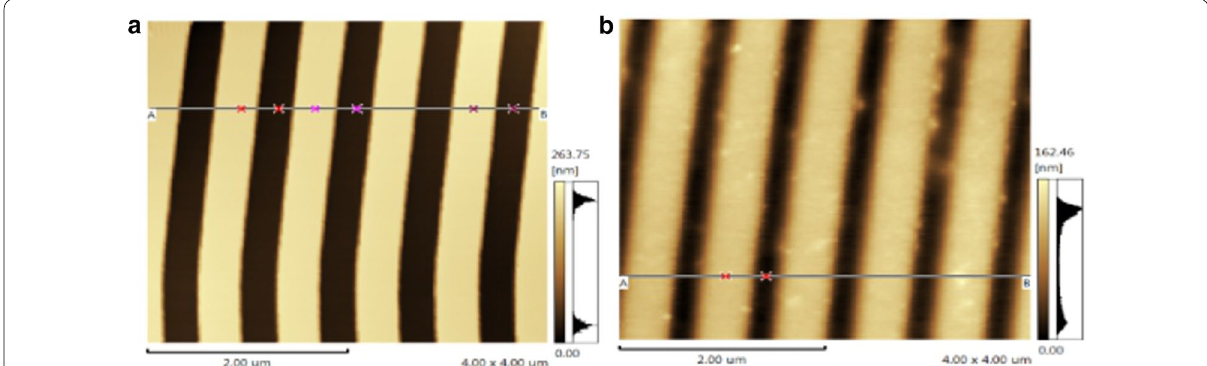
Fig. 5 AFM images of nanogratings: a Si nanograting template, b nanoreplica molding gratings on PDMS